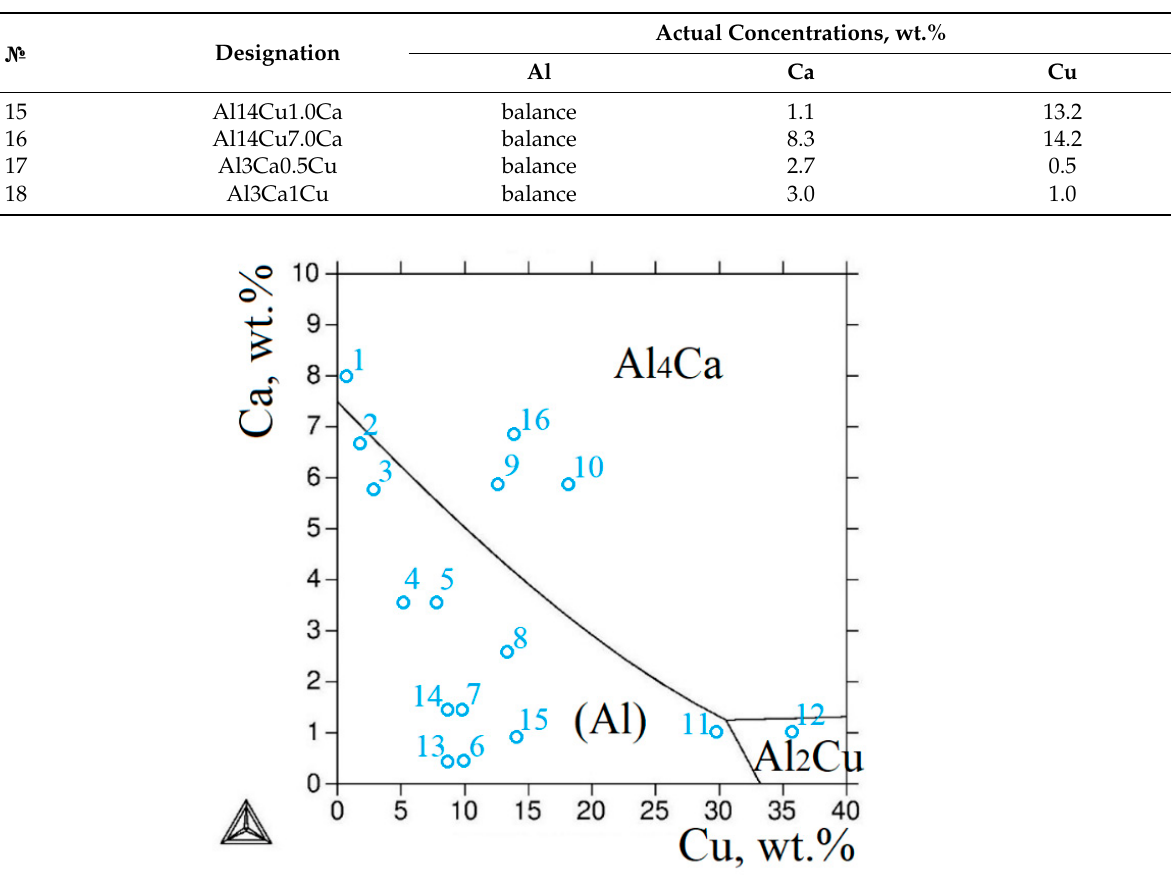
Figure 1. Composition of the chosen experimental alloys marked on the liquidus projection of the Al-Ca-Cu system calculated using Themo-Calc